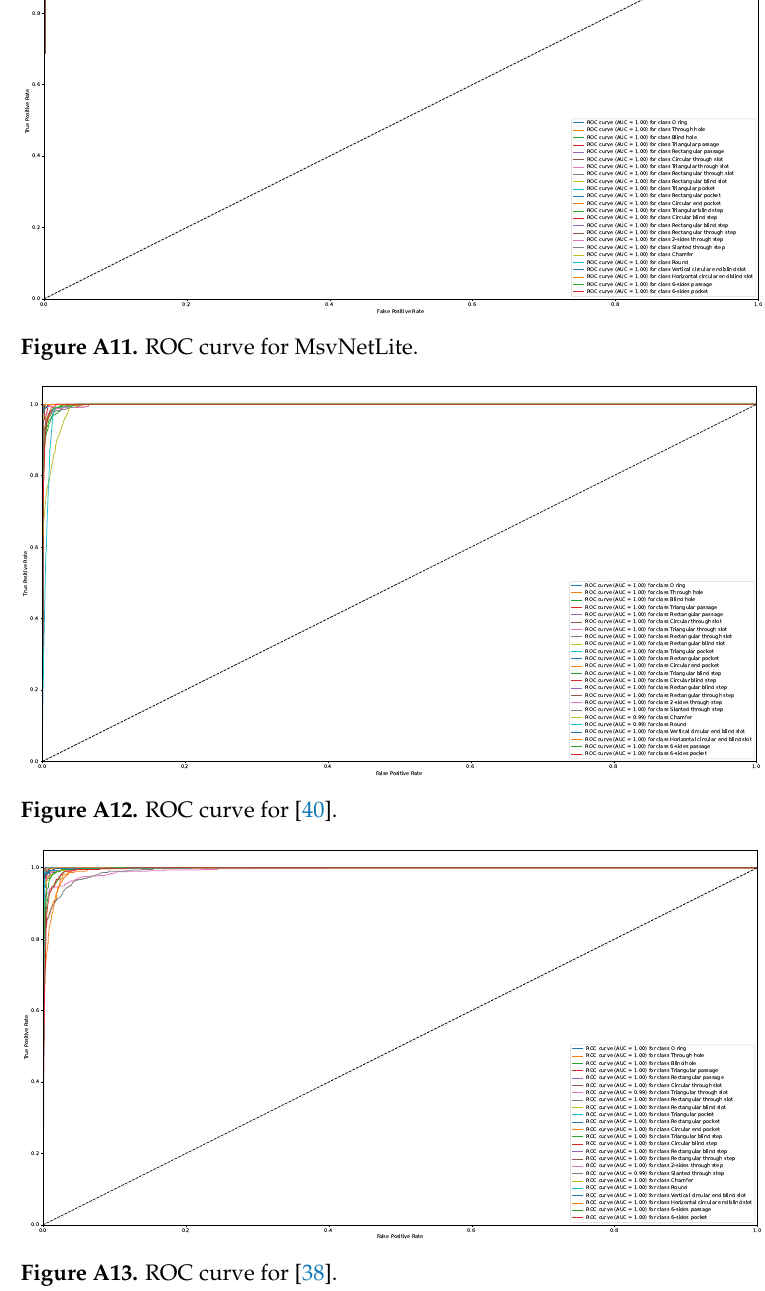
Figure A13. ROC curve for